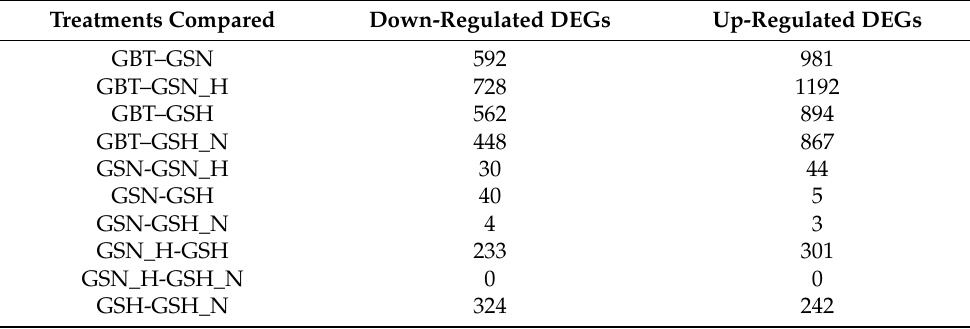
Table 1. The number of down and up-regulated DEGs by paired features. Treatments